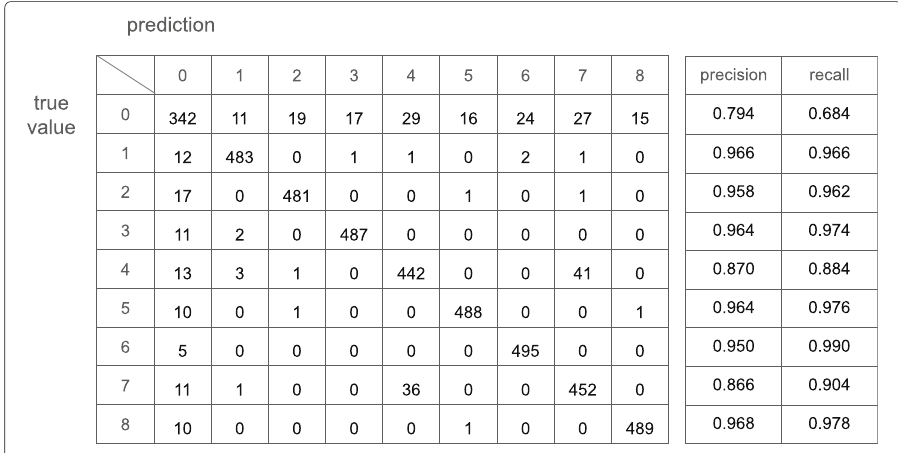
Fig. 14 The confusion matrix is from GAF-CNN without using pooling layers with closing, upper shadow, lower shadow, and real-body (CULR) feature set. The accuracy is 92.42% on average